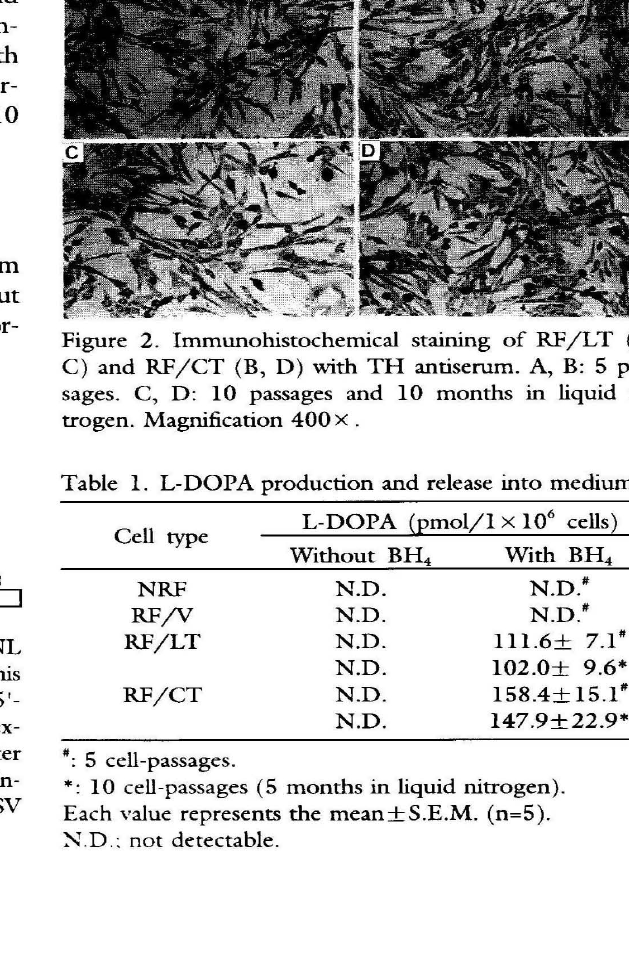
Figure I . Structure of DGL, LTHSNL and CTHSNL